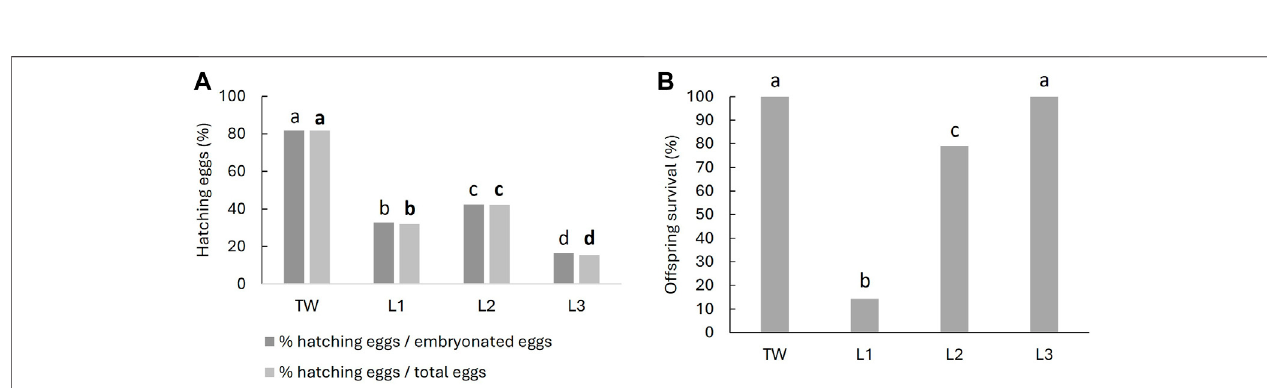
FIGURE 5 | (A) : Percentage of hatching eggs and (B) : Percentage of offspring survival at the fi rst month after the start of the bioassay in Biomphalaria straminea . EggmassesweretreatedwithwaterfromLuganoLake(L1,L2,andL3sites)untilhatching.Afterhatching,juvenilesweretransferredtotapwater(TW).Also,eggmasses in TW were transferred, after hatching, to clean TW. Statistical differences between sites are indicated with different letters (Chi-squared test, p < 0.05).